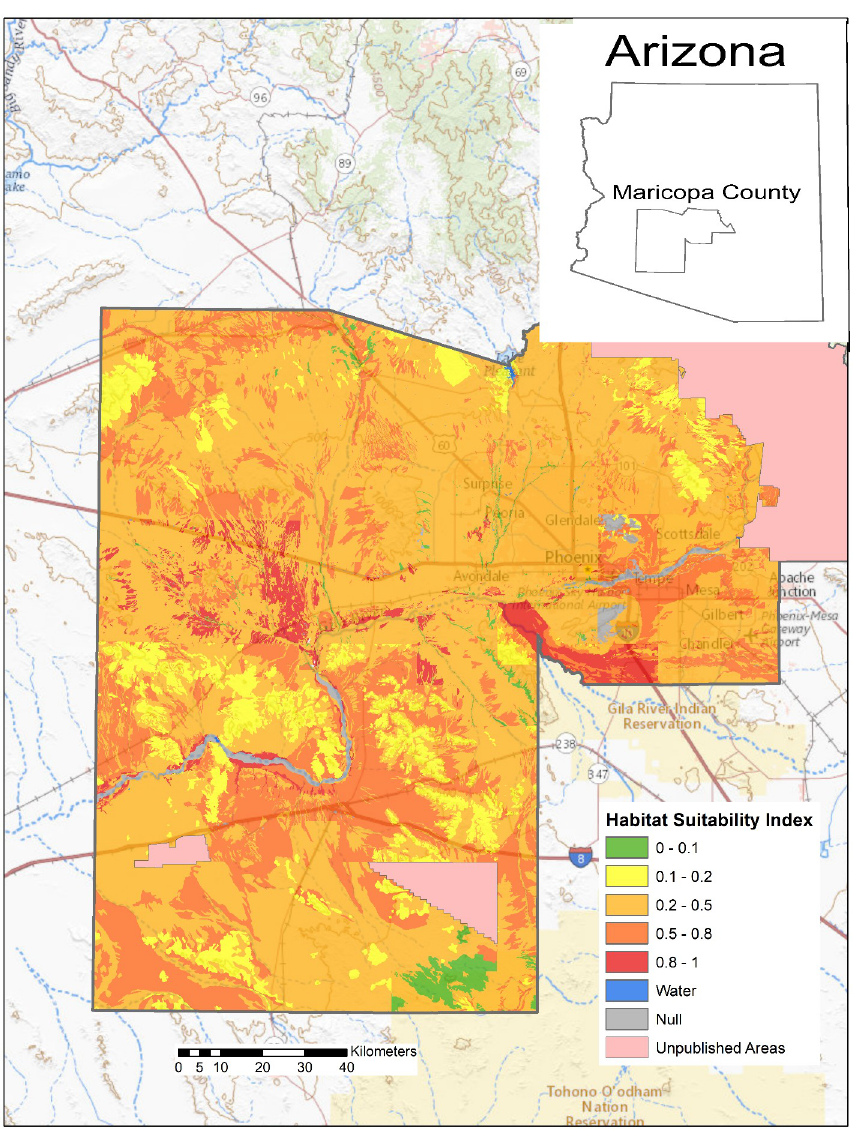
Fig 3. Predicted Coccidioides habitat suitability index for Maricopa County, Arizona, which has the highest incidence of coccidioidomycosis in the state.